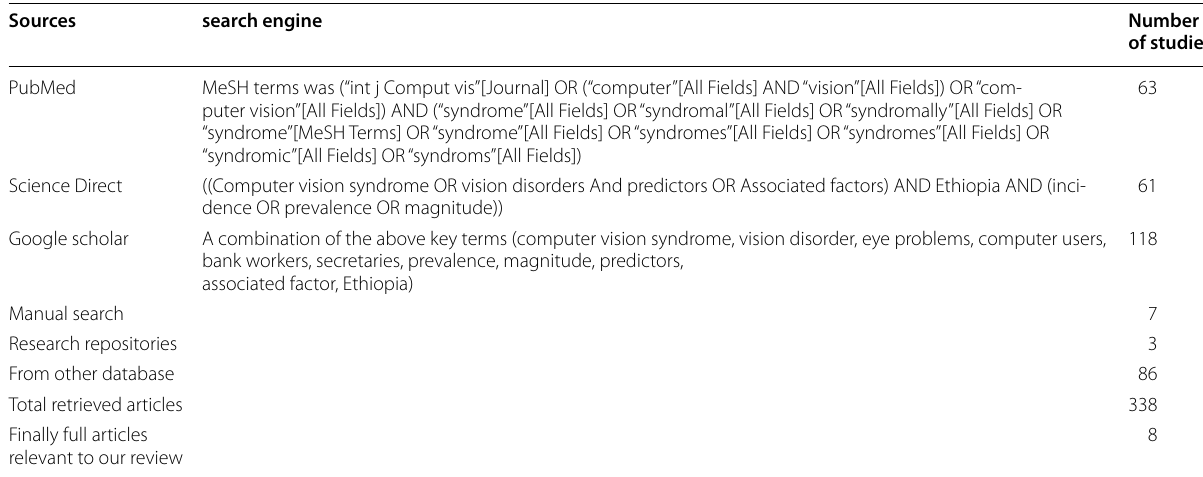
Table 1 Example of MEDLINE/PubMed and Google Scholar database searches to analyze the prevalence and predictors of Computer Vision Syndrome among employees who use the computers in